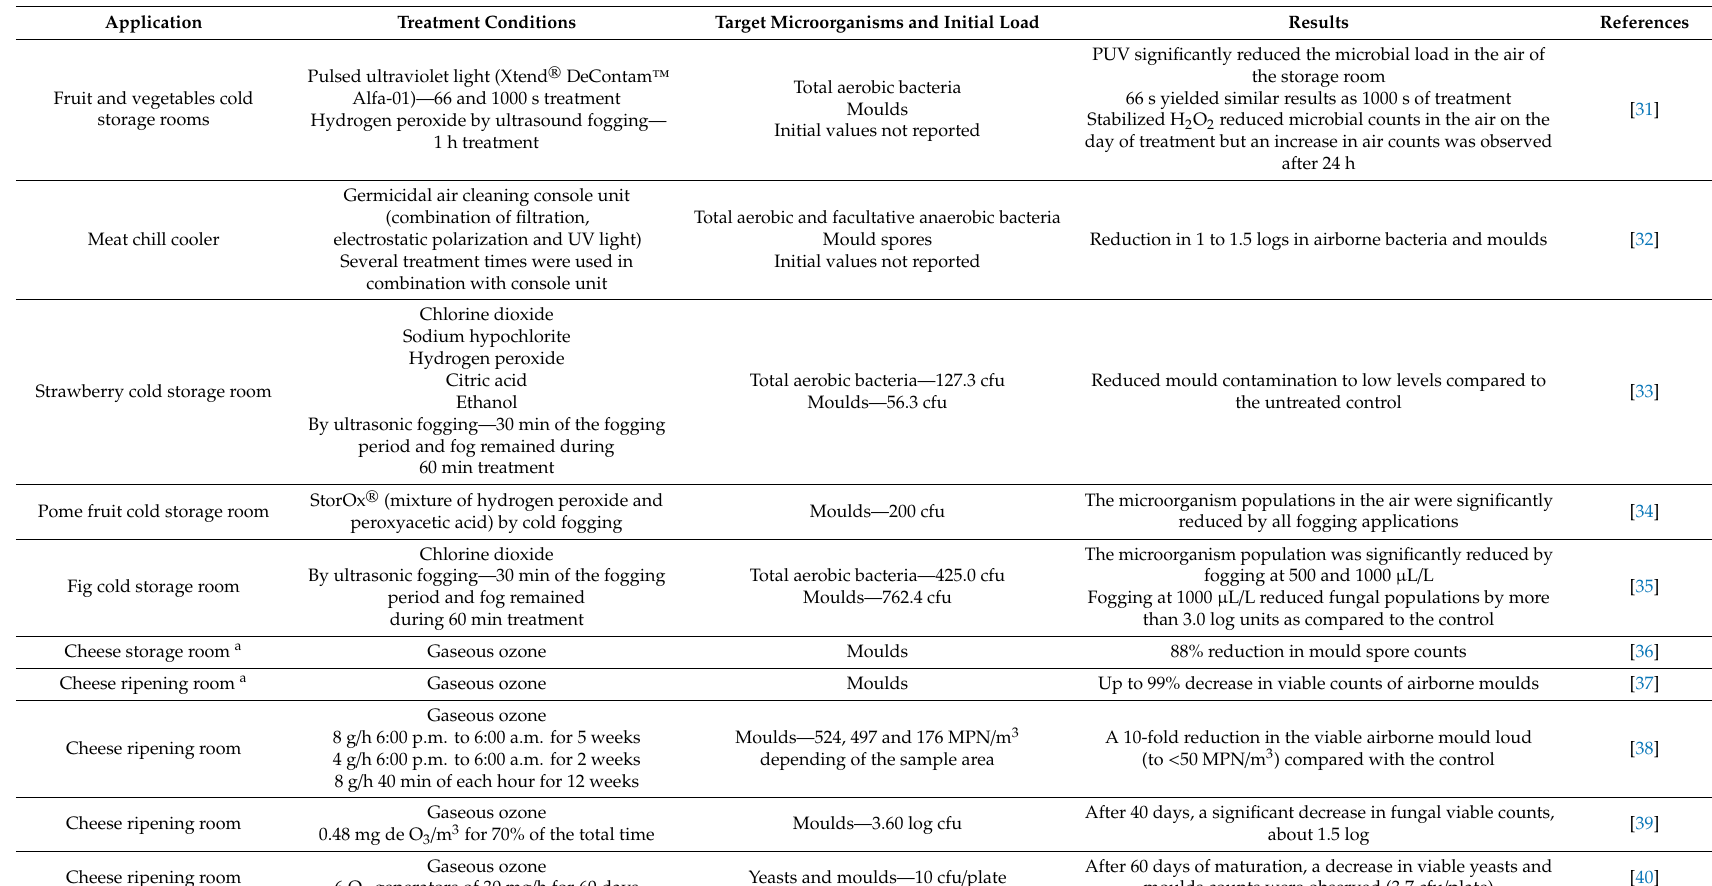
Table 1. Current technologies for decontamination of air in cold storage room in food processing